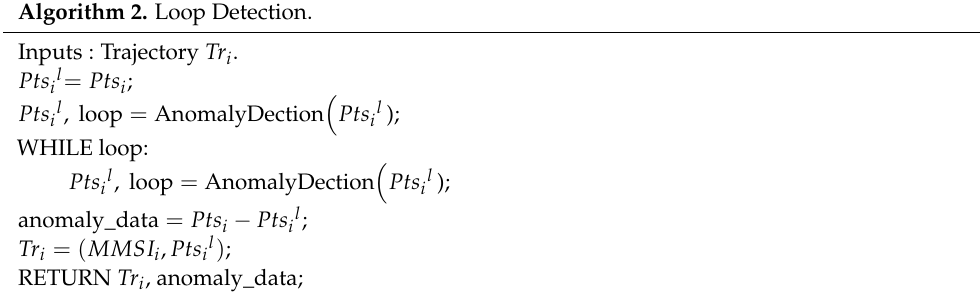
Algorithm 2. Loop